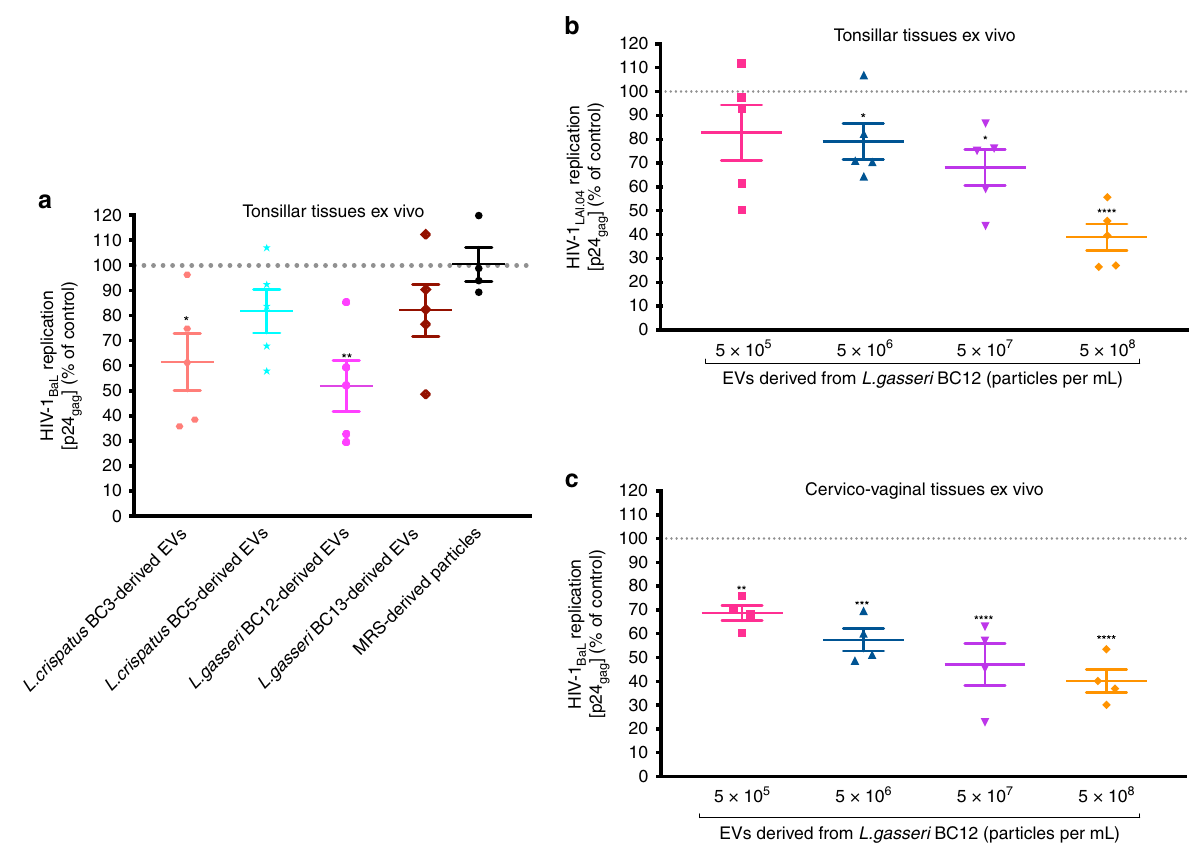
Fig. 4 Antiviral activity of Lactobacillus -derived EVs in human ex vivo tissues. Tonsillar tissue blocks were infected with EV-pretreated HIV-1 BaL and cultured for 12 days, with replacement every 3 days of tissue culture medium containing EVs obtained from L. crispatus BC3, L crispatus BC5, L. gasseri BC12, L. gasseri BC13, or particles derived from MRS medium. Replication of HIV-1 was evaluated from measurements of the capsid protein p24 gag in tissue culture medium and is represented as a percentage of HIV-1 replication in untreated control. a Anti-HIV-1 effects of EVs released by L. crispatus BC3, L crispatus BC5, L. gasseri BC12, and L. gasseri BC13 (5 × 10 8 EVs per mL). b , c Concentration dependence of antiviral activity of L. gasseri BC12-derived EVs in human tonsillar tissues ex vivo infected with HIV-1 LAI.04 ( b ) and in cervico-vaginal tissues ex vivo infected with HIV-1 BaL ( c ). Presented are means ± SEM from tissues of at least four donors. Asterisks indicate statistical signi fi cance by one-way ANOVA multiple comparison with Dunnett ’ s correction (* p < 0.05, ** p < 0.01, *** p < 0.001, **** p < 0.0001). Source data are provided as a Source Data fi